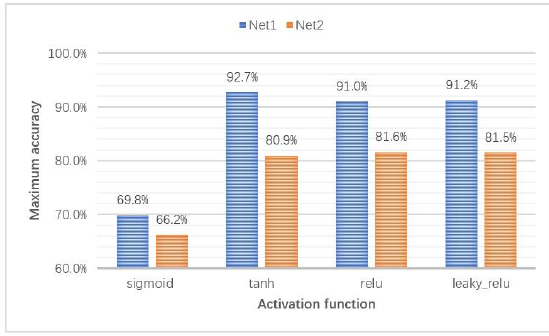
Figure 11: Different network identification results of raw